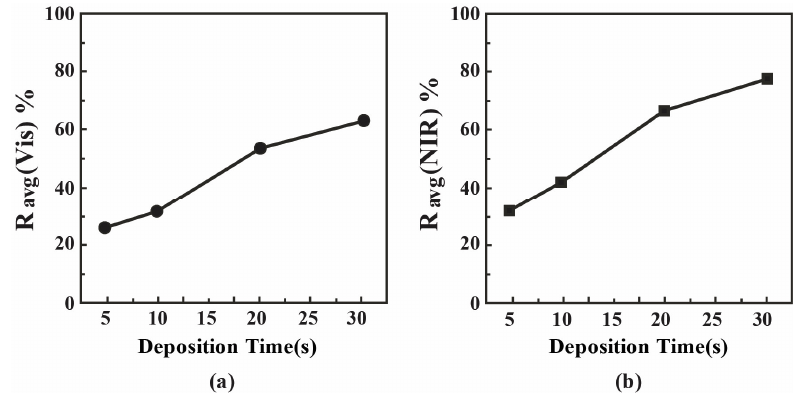
Figure 8. Average spectral reflectance in ( a ) Vis and ( b ) NIR ranges.